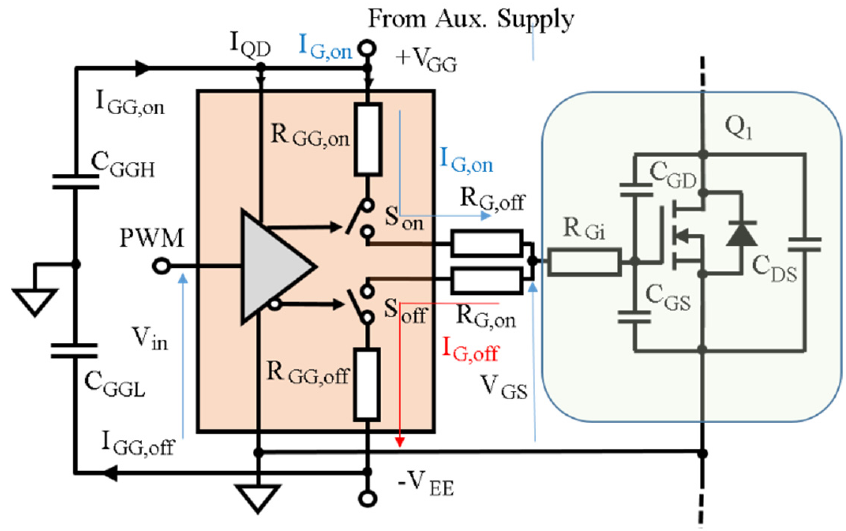
Figure 4. A simplified gate driver circuit and power MOSFET with inner resistance and capacitors